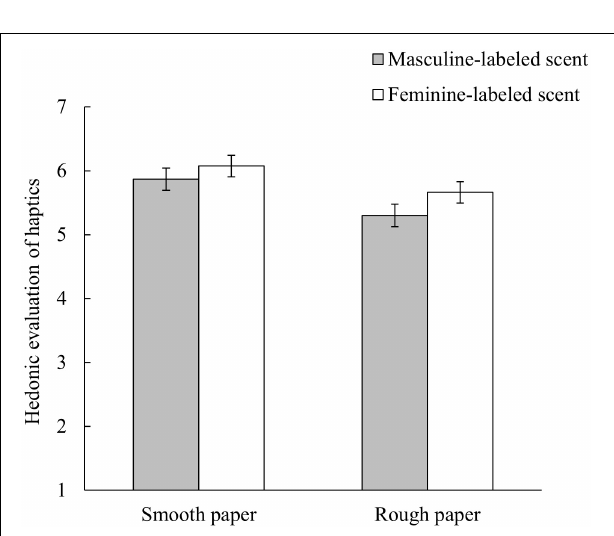
FIGURE 4 | Effects of gender labeling of scent on hedonic evaluation of haptics. Error bars indicate standard errors.